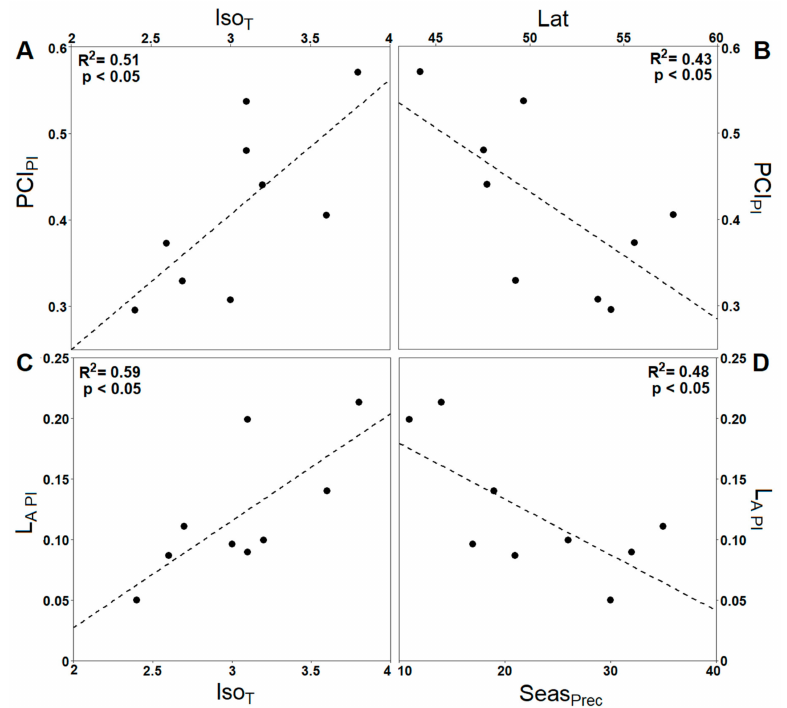
Figure 5. Linear regression results showing the relationship between isothermality ( Iso T , ( A , C )), latitude ( Lat , ( B )) and precipitation seasonality ( Seas Prec , ( D )) of the provenance’s original site and plasticity indices ( L A PI , PCI PI ).